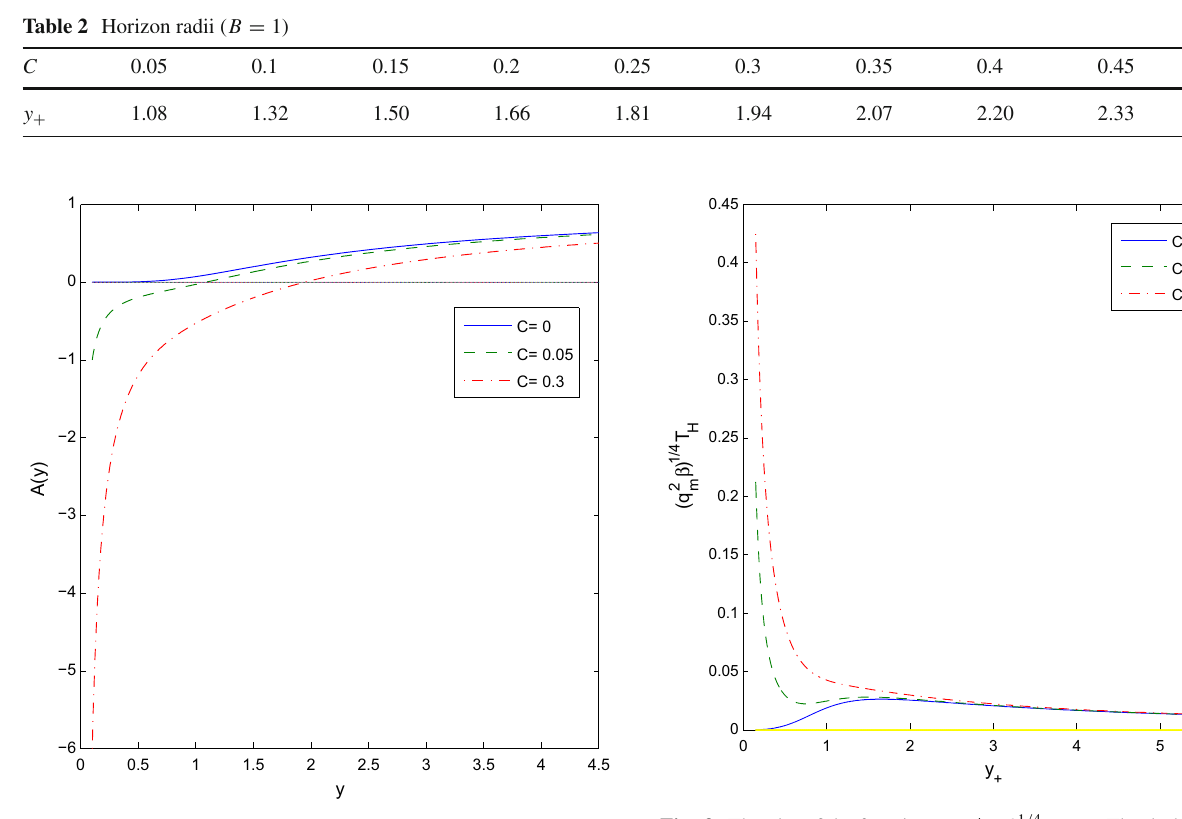
Fig. 2 The plot of the function A ( y ) for B = 1. The dashed curve corresponds to C = 0 . 05, the solid curve is for C = 0, and the dash- dotted curve corresponds to C = 0 . 3